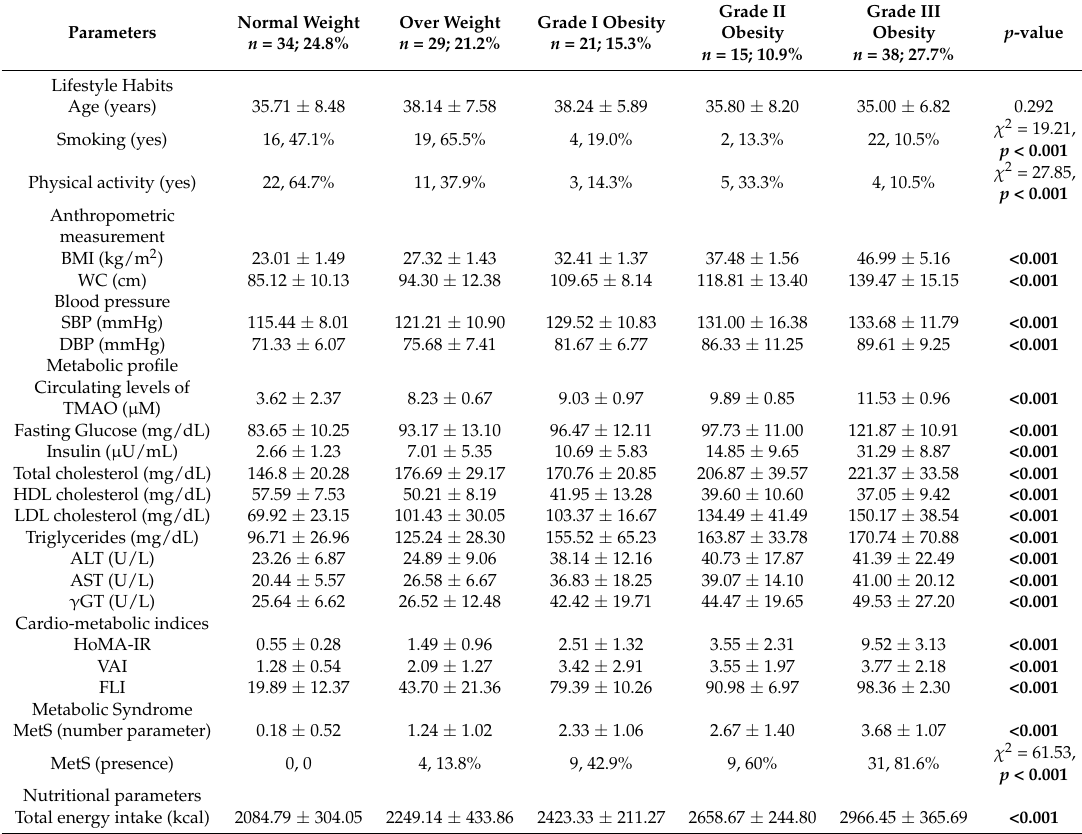
Table 1. Lifestyle habits, anthropometric characteristics, blood pressure, metabolic profile, cardio-metabolic indices, and total energy intake of participants grouped based on BMI categories.